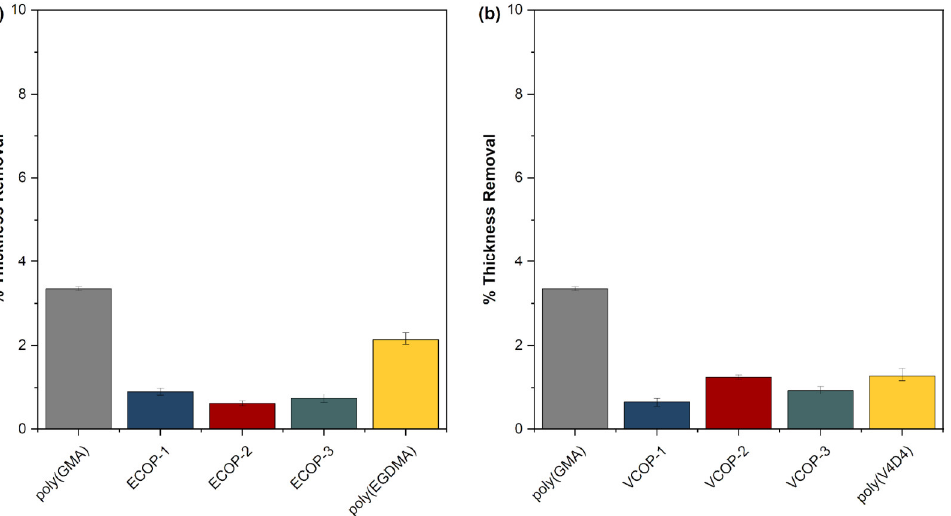
Figure 11. Relative change in film thickness of homo and ( a ) poly(GMA-co-EGDMA) ( b ) poly(GMA- co-V4D4) copolymer coatings immersed in 5 wt. % NaCl solution for 24 h.